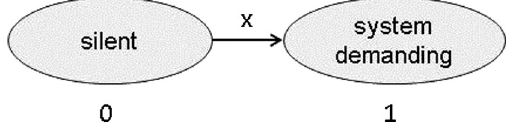
FIG. 7. State diagram reflecting system demand.